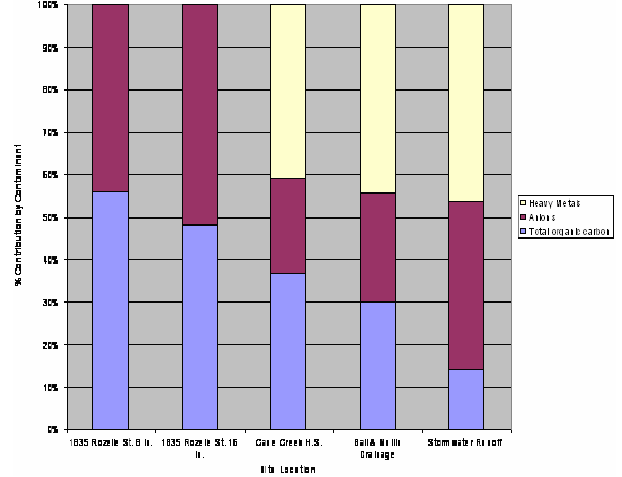
Figure 7: Weighted Contamination versus